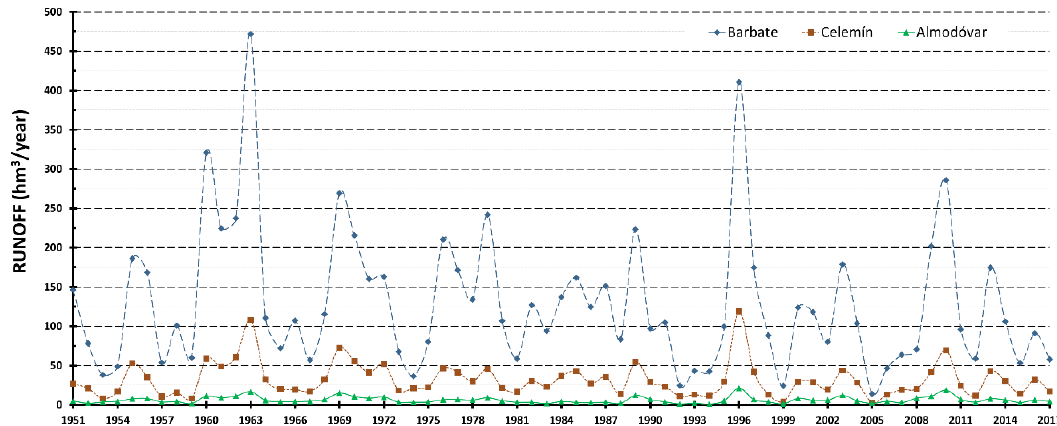
Figure 7. Annual runoff time series from the T-RRM (time period ranging from 1951 to 2017).